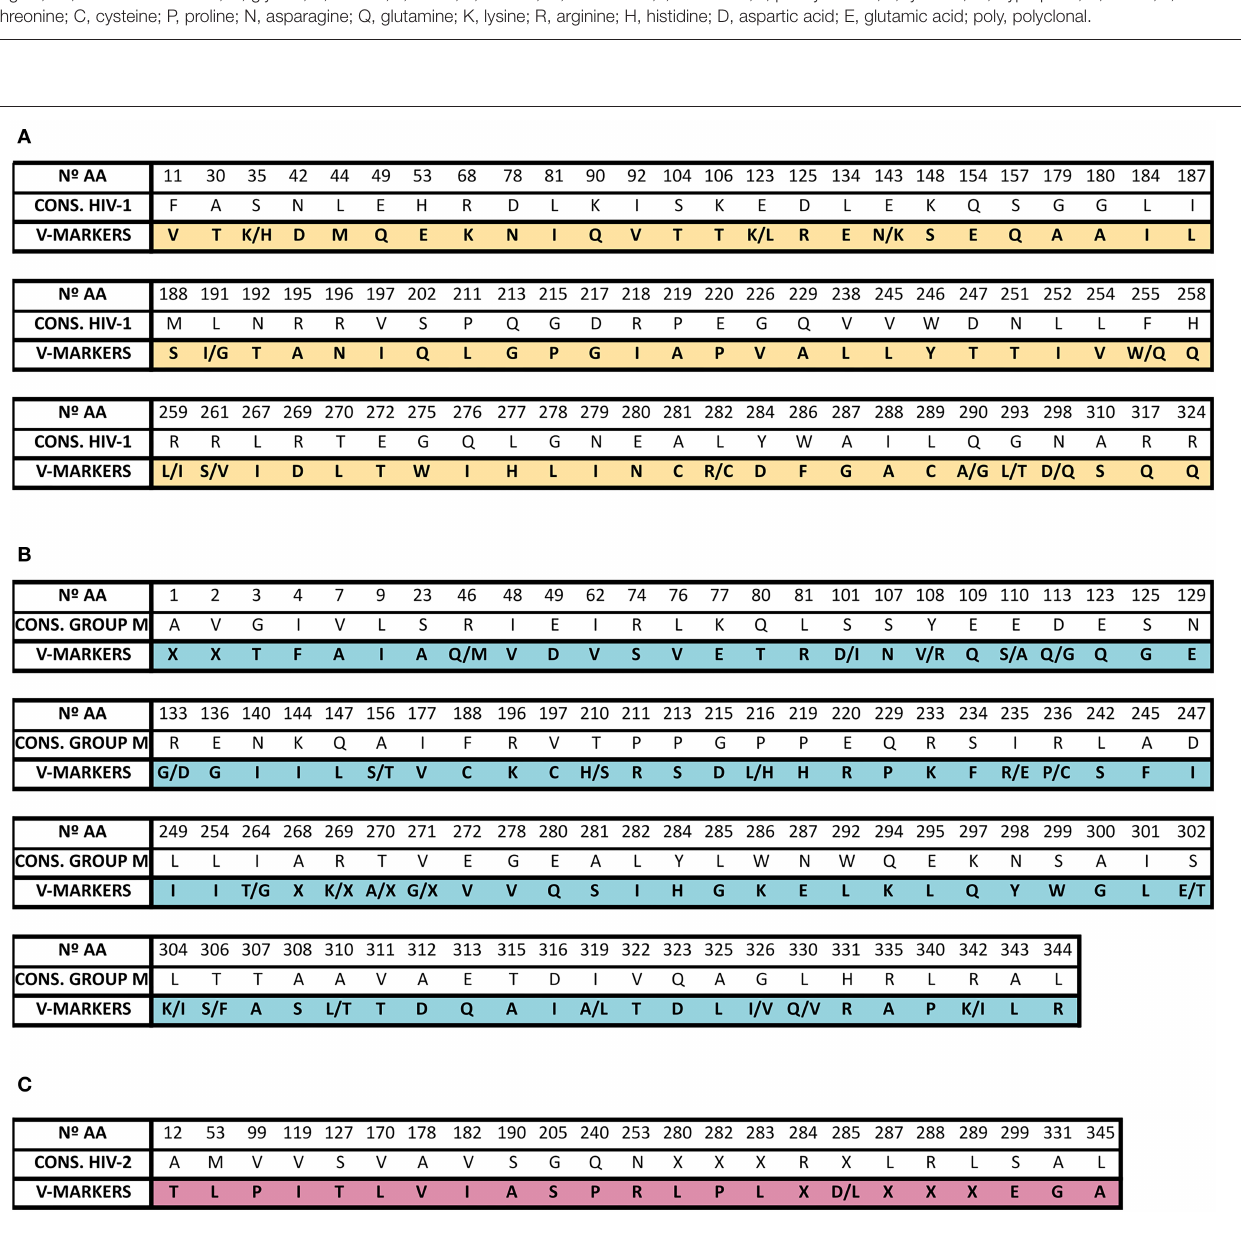
FIGURE 3 | conserved < 90%), light-blue (aa conserved ≥ 90%– < 100%), and dark blue-green (aa conserved 100%). Anti-gp41 human antibodies include bnAbs and non-bnAbs described in Los Alamos HIV Immune Database (Los Alamos HIV Molecular Immunology Database, 2021a). Linear epitopes are shown in blue and non-linear epitopes, recognized by broadly neutralizing antibodies (bnAbs), are shown in orange. We also indicated the T-20 fusion inhibitor binding domain in red (T-20BD). N ◦ , number; AA, amino acids; SEQS, sequences; Cons, aa consensus sequence; FP, fusion peptide; FPPR, fusion peptide proximal region; NHR, N-terminal alpha-helical region; IL, immune-dominant linker; CHR, C-terminal heptad repeat region; MPER, membrane-proximal external region; TM, transmembrane region; CT, C-terminal domain; G, glycine; A, alanine; V, valine; L, leucine; M, methionine; I, isoleucine; F, phenylalanine; Y, tyrosine; W, tryptophan; S, serine; T, threonine; C, cysteine; P, proline; N, asparagine; Q, glutamine; K, lysine; R, arginine; H, histidine; D, aspartic acid; E, glutamic acid; poly, polyclonal.